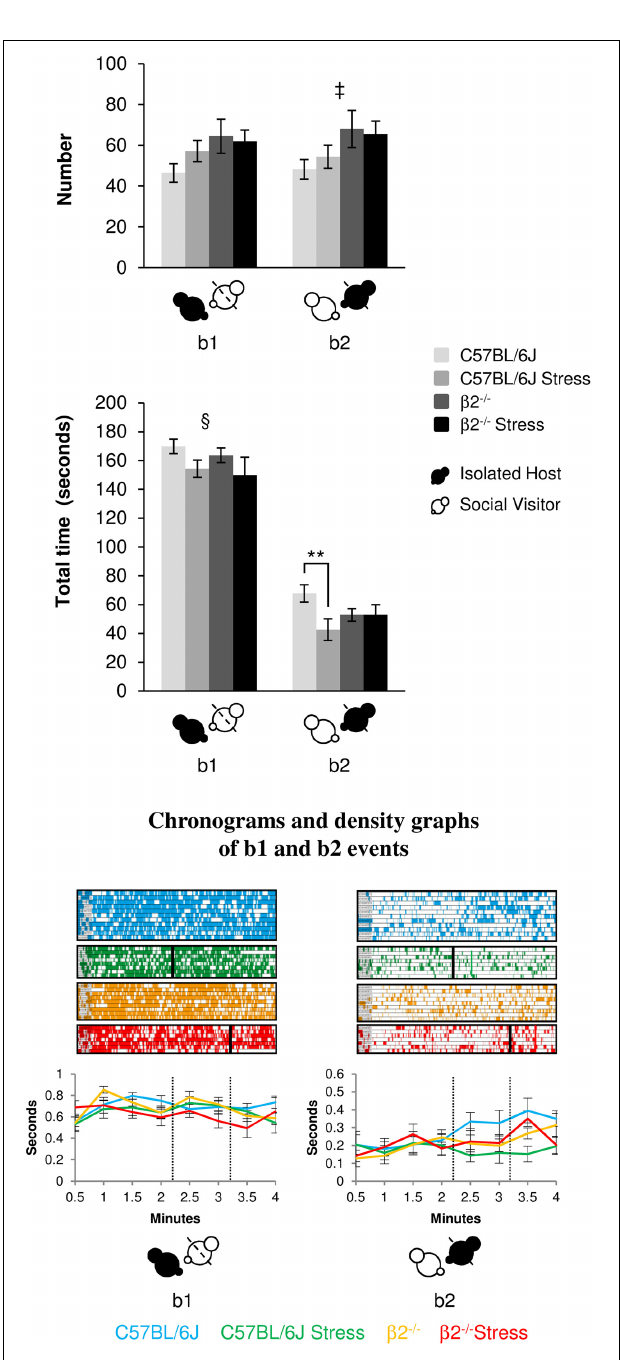
FIGURE 2 | Relative position events during social interaction. Histograms ( Top ) showed the number and the total time of the relative position events (b1 and b2 as referred in Table 1 and Supplementary Table 1) between IH and SV, quantified during the 4min of the social interaction task. IH mice were submitted or not to an acute stress. Data are expressed as means ± SEM. ∗∗ p ≤ 0 . 01, ‡ Genotype effect: p = 0 . 021, § Stress effect p = 0 . 035. Chronograms and density graphs ( Bottom ) illustrated the temporal evolution of the aforementioned b1 and b2 events throughout the 4min of the experiment. In the chronograms, each line represents one dyad of IH - SV mice in a specific group. The length of each point is proportional to the duration of events. In the graphs, (Continued)